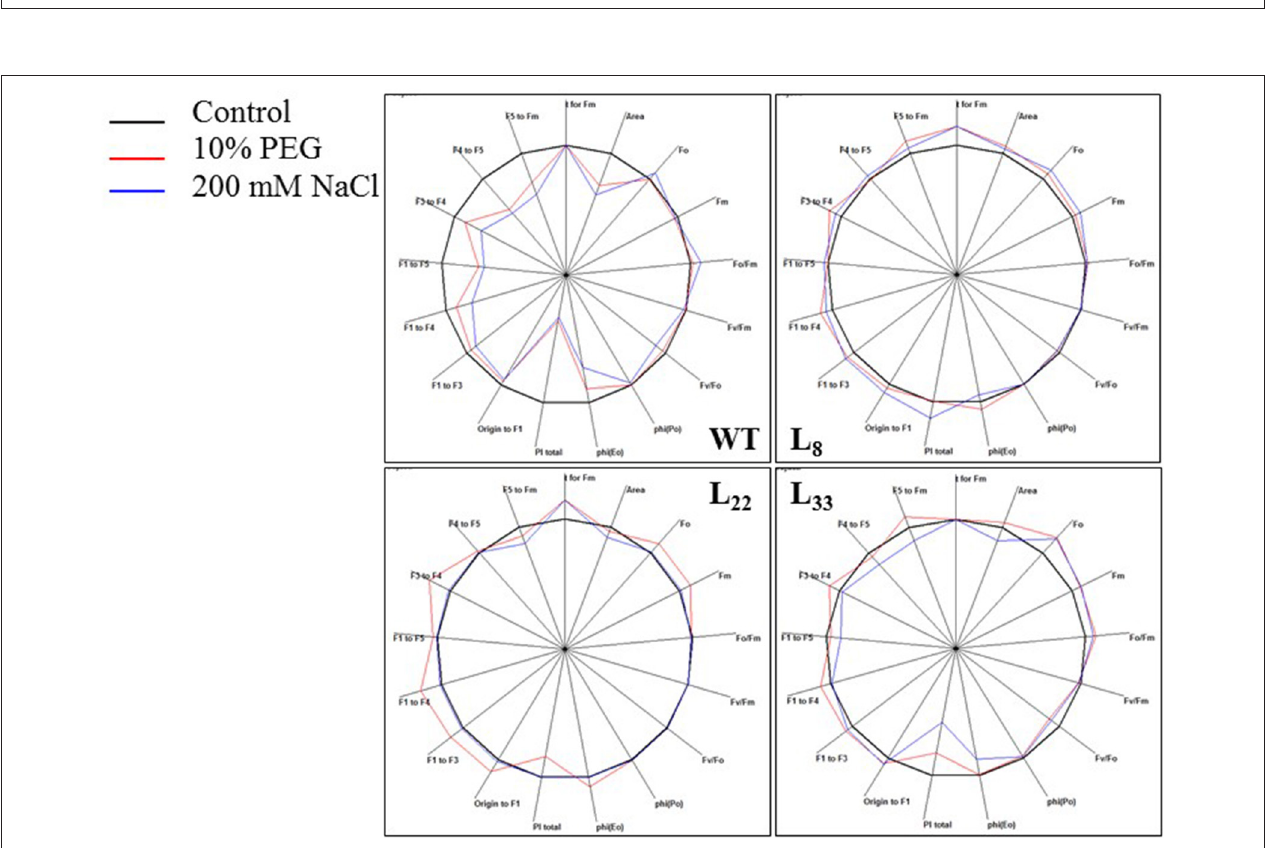
FIGURE 9 | Photosynthetic efficiency of WT and transgenic tobacco. Spider plots of photosynthetic fluxes depicting behavior of Photosystem II in leaves of WT and transgenic (L 8 , L 22 , and L 33 ) tobacco under control and stress (drought and salt)